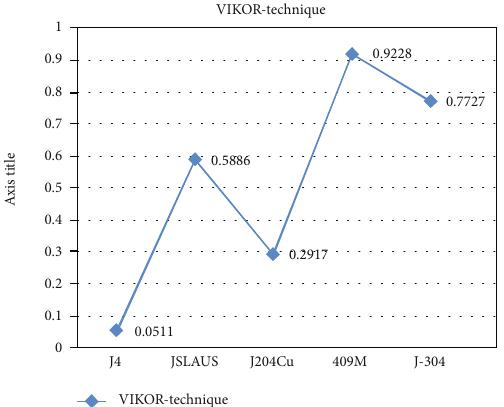
Figure 1: Crisp VIKOR application for evaluating EAI of TEHES tube materials under TEHES-O-S-tube material evaluation dimensions.